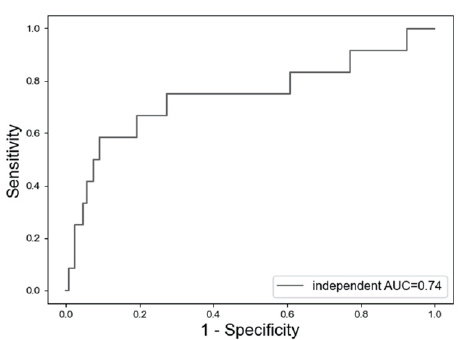
Figure 4. Receiver operating characteristics for the prediction of clinical refractures in the independ- ent dataset using the LightGBM model. AUC: area under the curve. dataset using the LightGBM model. AUC: area under the